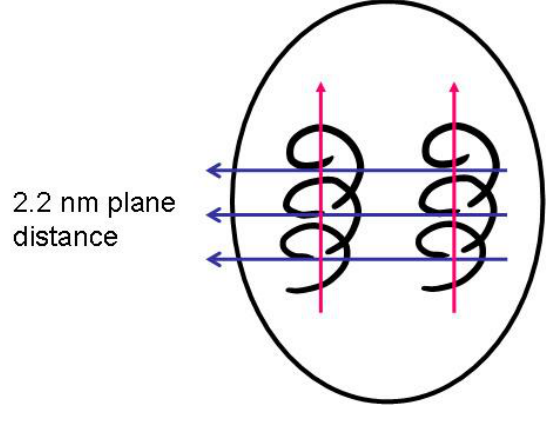
Figure 10. Structure model for the primary particle after completed